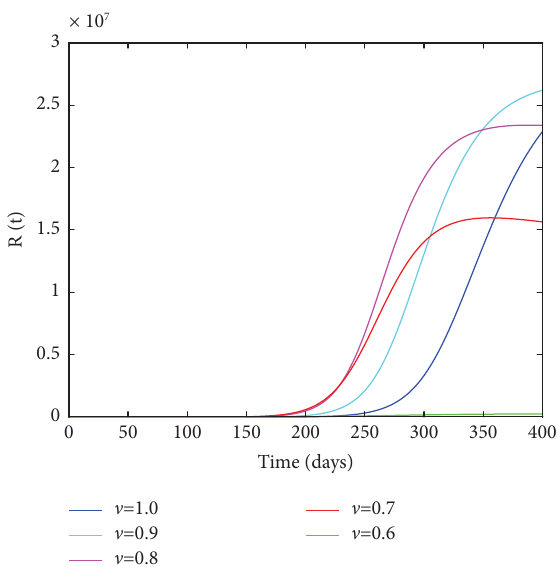
Figure 8: Behaviour of the recovered individuals at diferent values of v